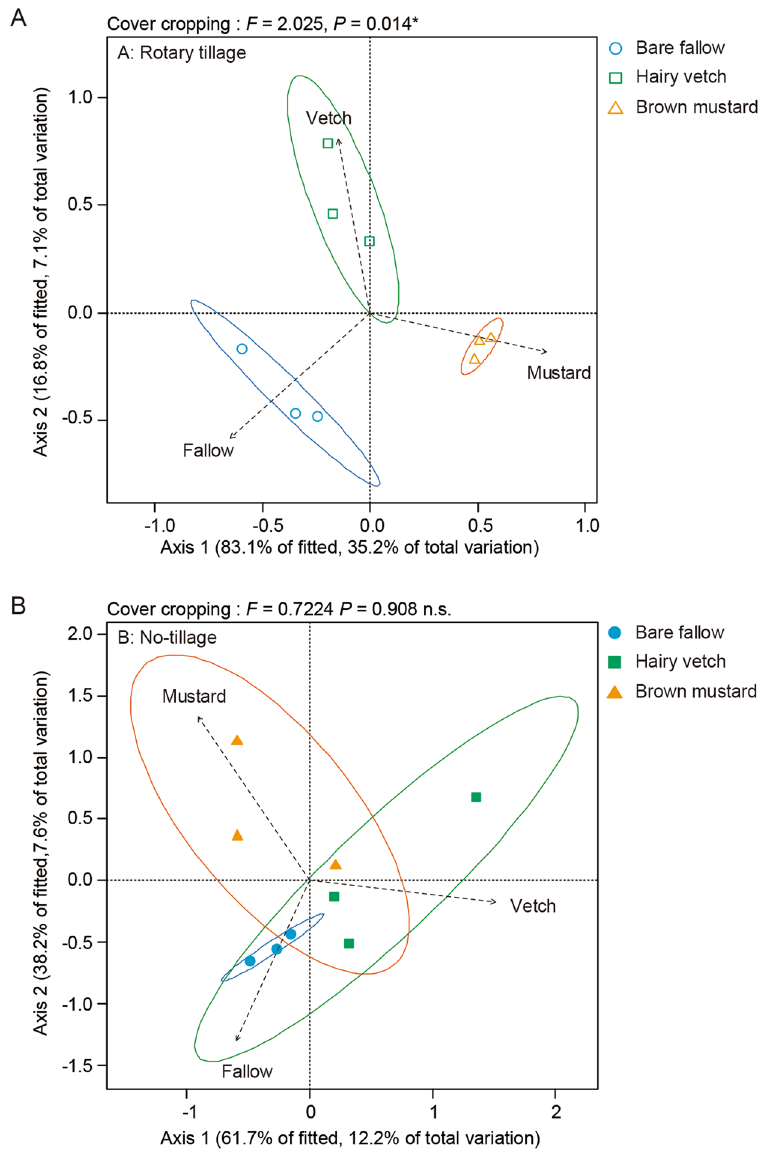
Figure 6. Distance-based redundancy analysis (db-RDA) of the influence of cover crop type in each tillage management system on the communities of arbuscular mycorrhizal fungi (AMF) in the maize roots. Dashed lines explain the effect of each type of cover crop. Ellipses represent 95% confidence intervals. A: rotary tillage, B: no tillage. All analyses and Fig. 6 were run and created in the software environment RStudio (Version 1.2.1335 – © 2009–2019 RStudio, Inc.)